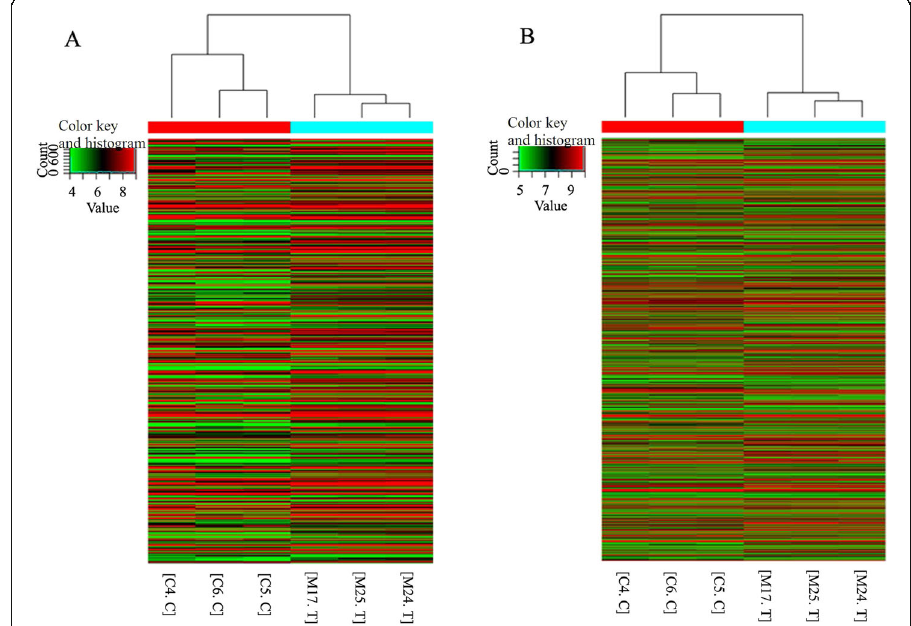
Fig. 2 Heat map and hierarchical clustering of lncRNA ( a ) and mRNA ( b ) differential expression profiles between the border zone of myocardial infarction and the control zone of sham operation groups. “ Red ” indicates high relative expression, and “ Green ” indicates low relative